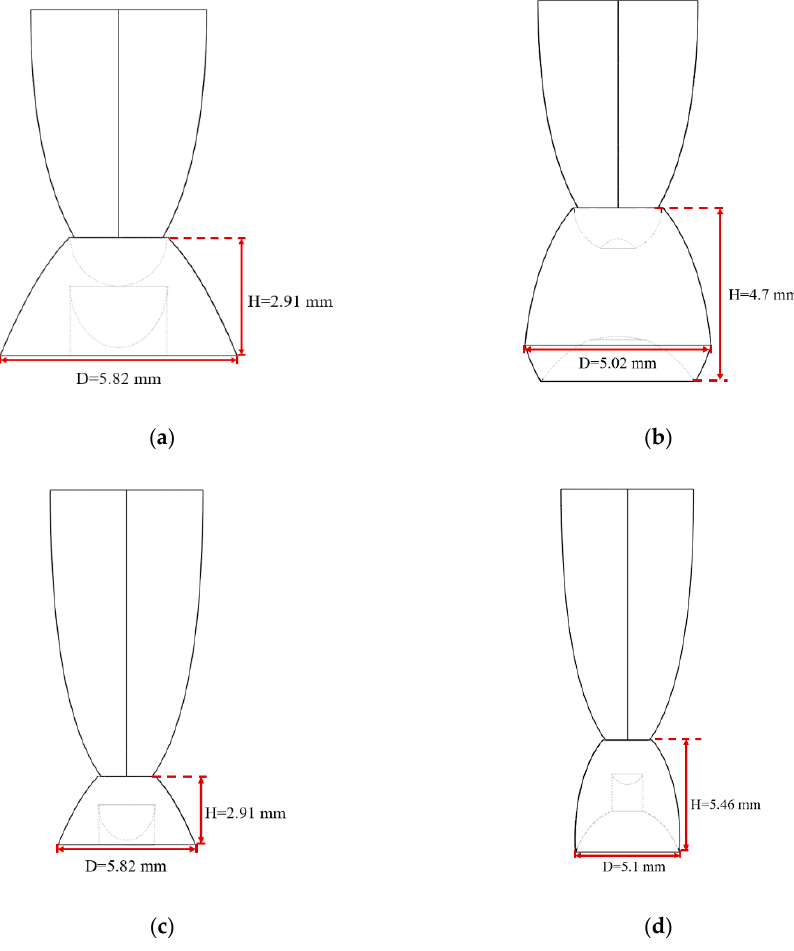
Figure 18. The four cases and sizes of misalignment light-guiding units: ( a ) the mirror-NACPC with the TIR collimator; ( b ) the mirror-NACPC with the elliptical collimator; ( c ) the solid-NACPC with the new TIR collimator; ( d ) the solid-NACPC with the new elliptical collimator.